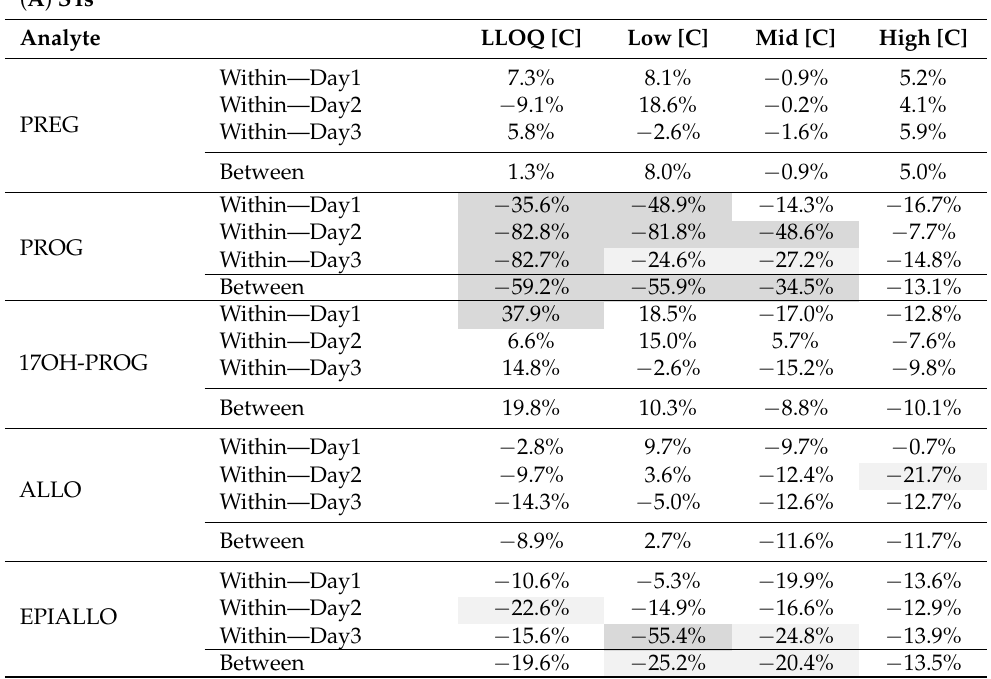
Table 7. Within- and between-run accuracy for steroids (STs) ( A ) and cannabinoids (CBs) ( B ) at low, mid, and high concentration levels [C] (corresponding to CC2, CC4, and CC8 concentration levels, respectively, of the calibration